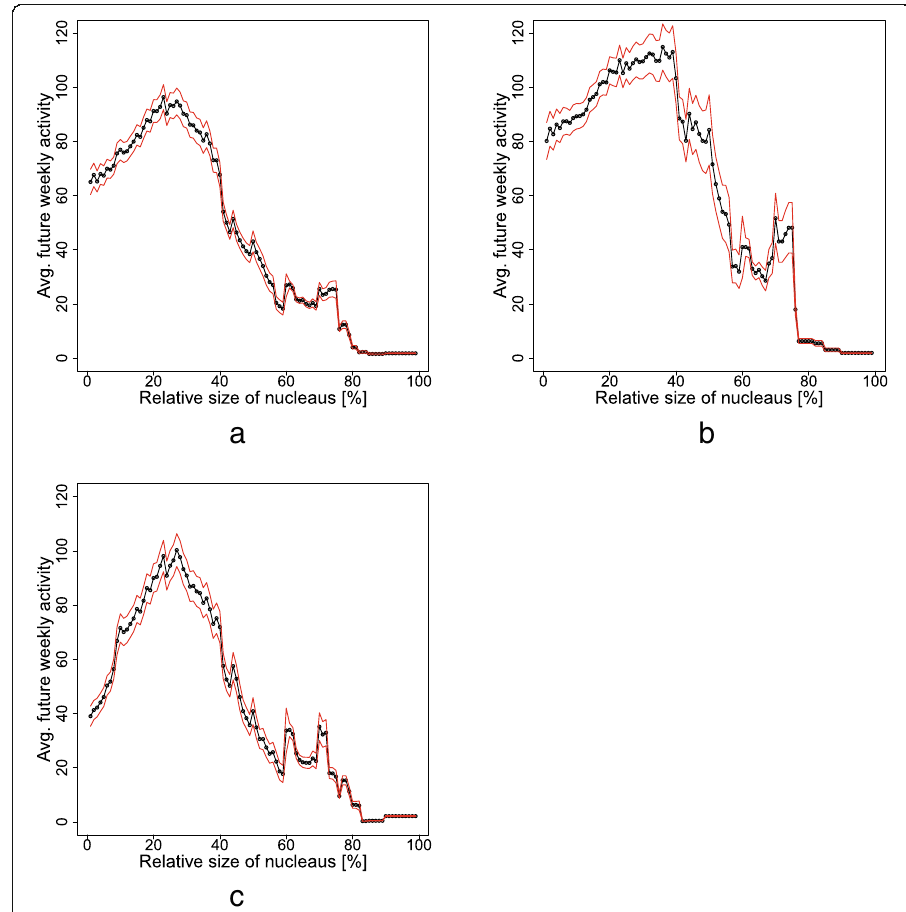
Fig. 11 Future activity ^ A of a community as a function of the fraction of actors in the nucleus N. Members of the nucleus are defined to have a local clustering coefficient of 1 and are identified on the network, per each time slice. Future activity is the total of messages posted during a 60-day time frame following the identification of nucleus members. Mean future activity per nucleus size is shown in black (standard error in red). a The calculation across all 10,122 communities. b The subset of long-lived communities (above-median lifetime). c The short lived communities (below median